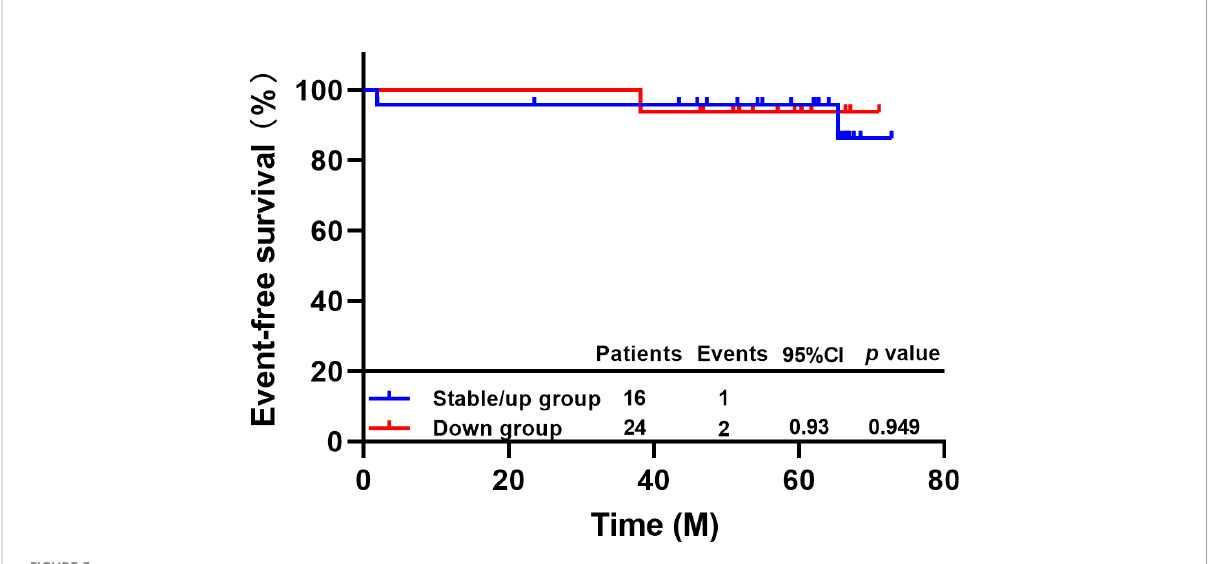
FIGURE 3 EFS of patients with different changes in CTC by TUMORFISHER